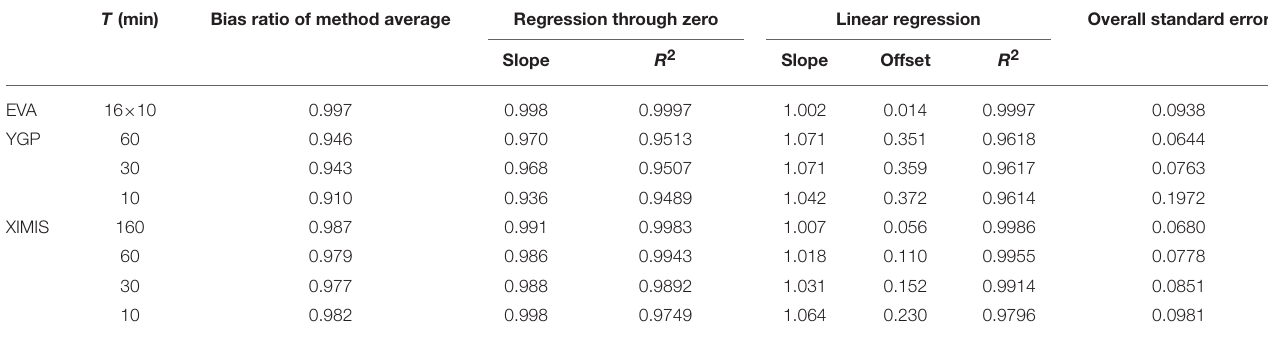
TABLE 2 | Summary of method performance and variability. T (min) Bias ratio of method average Regression through zero Linear regression Overall standard error